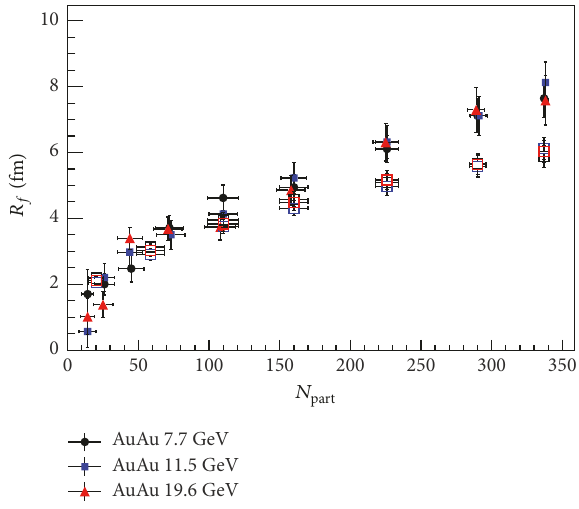
Figure 6: The kinetic freeze-out radius (solid symbols) as a function of collision centrality for Au+Au collisions at 7.7GeV (black sym- bols),11.5 GeV(blue),and19.6 GeV(redsymbols).Theopensymbols are the chemical freeze-out radii obtained by STAR experiment